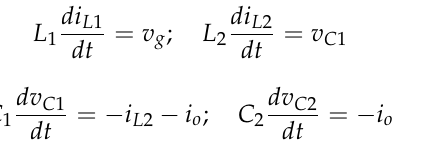
Figure 2. Pulse width modulation (PWM) scheme of the series-capacitor boost converter.